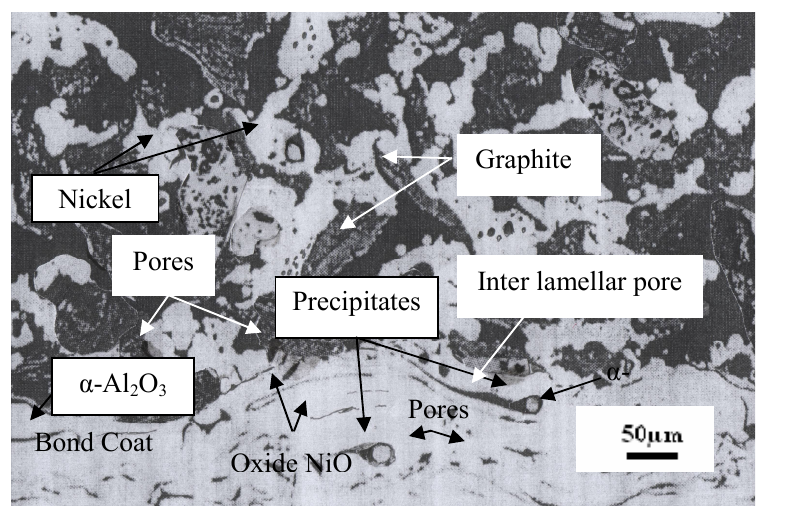
Figure 4 – Microstructure of NiAl / Ni-25% graphite layers deposited with 700A